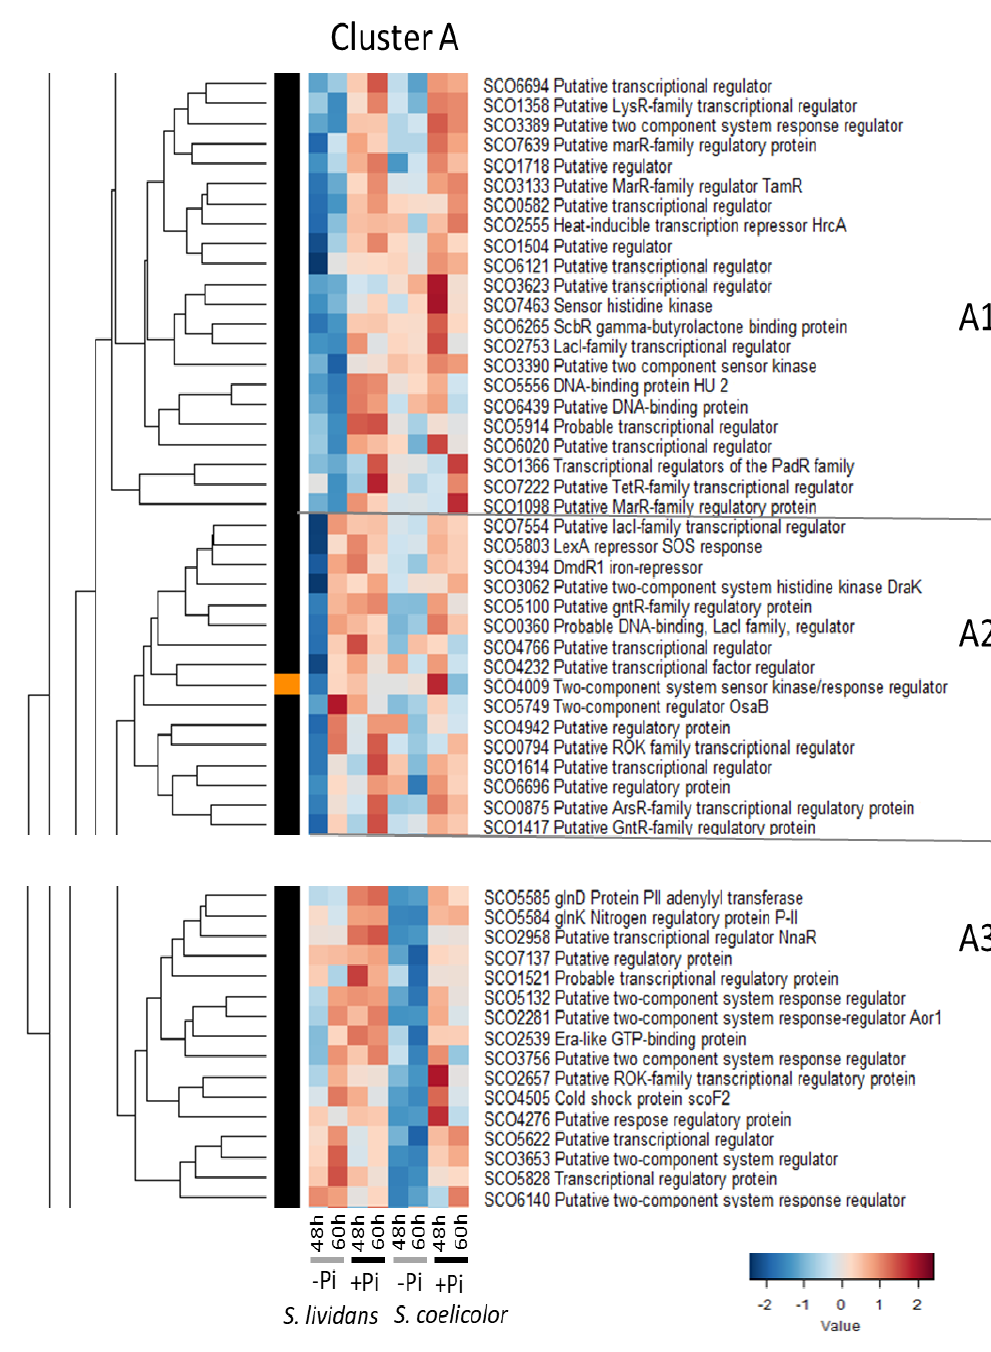
Figure 2. Cluster A, heatmap representation of transcriptional regulators and sensory histidine kinases more abundant in Pi proficiency than in Pi limitation in both strains. Cluster A that can be divided into 3 sub-clusters A1, A2 and A3. Sub-cluster A1 includes 22 regulators rather more abundant in Pi proficiency than in Pi limitation in both strains. The sub-clusters A2 and A3 both include 16 regulators that were similarly abundant in SL and SC in Pi proficiency at both time points but also abundant in SL in Pi limitation at 60 h.